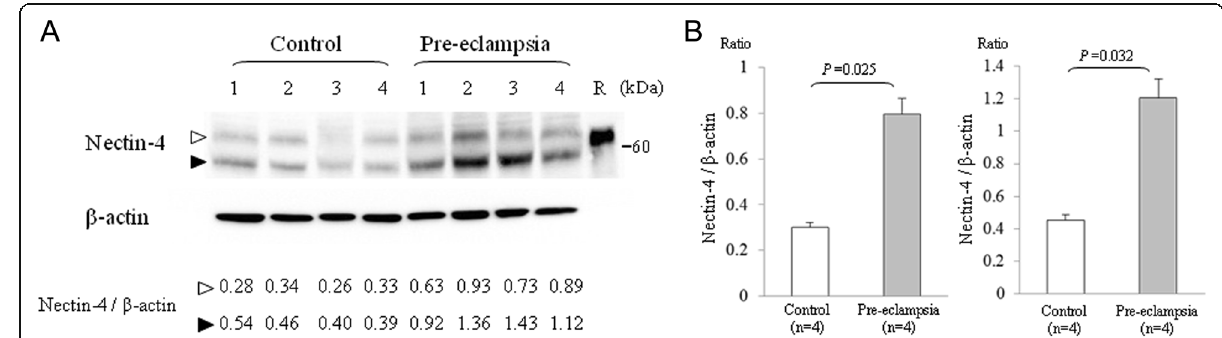
Fig. 2 Semi-quantitative western blot analysis of nectin-4. a The same blot was incubated against a nectin-4 antibody (upper panel) and a β -actin antibody (lower panel). Rabbit polyclonal anti-human nectin-4 antibodies we raised in this study were used. Lanes 1 – 4, lysates of placental tissue from uncomplicated normotensive pregnancies; lanes 5 – 7, lysates of placental tissue from pre-eclamptic pregnancies; lane R, recombinant nectin- 4. The data of western blot using commercial goat polyclonal antibodies was shown in Additional file 1: Figure S1. b Semi-quantitative analysis of the blot described in A. Data obtained from uncomplicated normotensive pregnancy (open bars) versus severe pre-eclampsia (grey bars) were compared. The left and right panels indicate the data for the upper bands (open triangle), and lower bands (close triangle), respectively. Each bar represents the mean value. Error bars indicate the standard